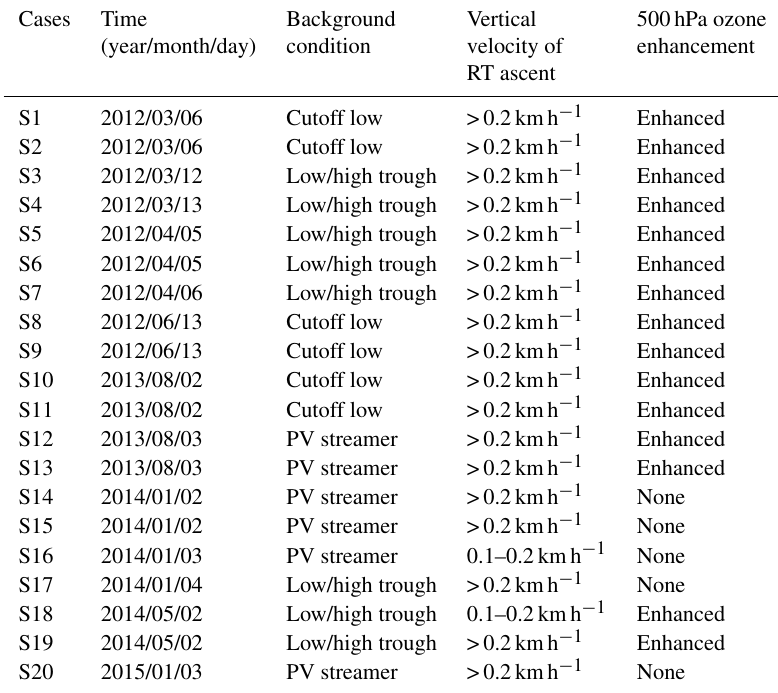
Table 2. Characteristics of the 20 cases shown in Fig. 11a.